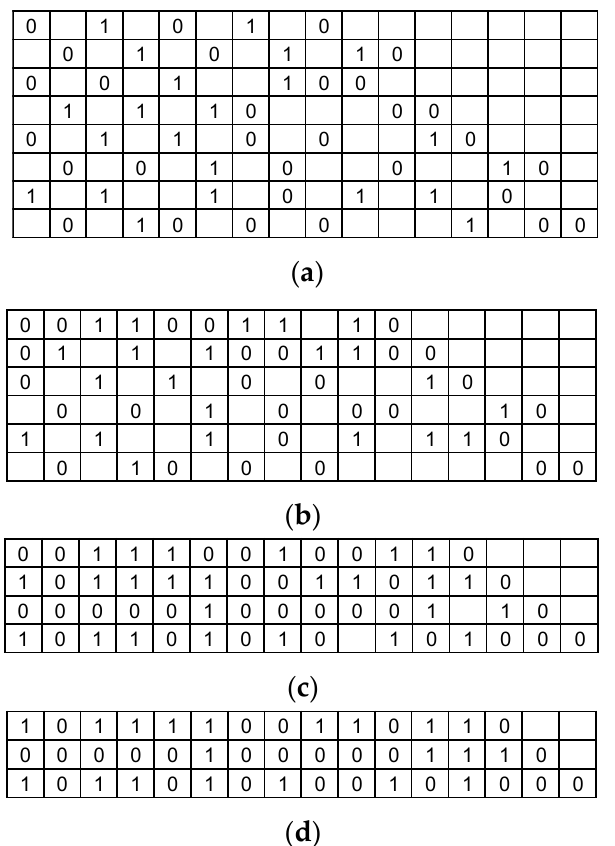
Figure 9. IEEE 802.11ay 2nd lifting matrix with R = ( a ) 1/2, ( b ) 5/8, ( c ) 3/4, and ( d ) 13/16.